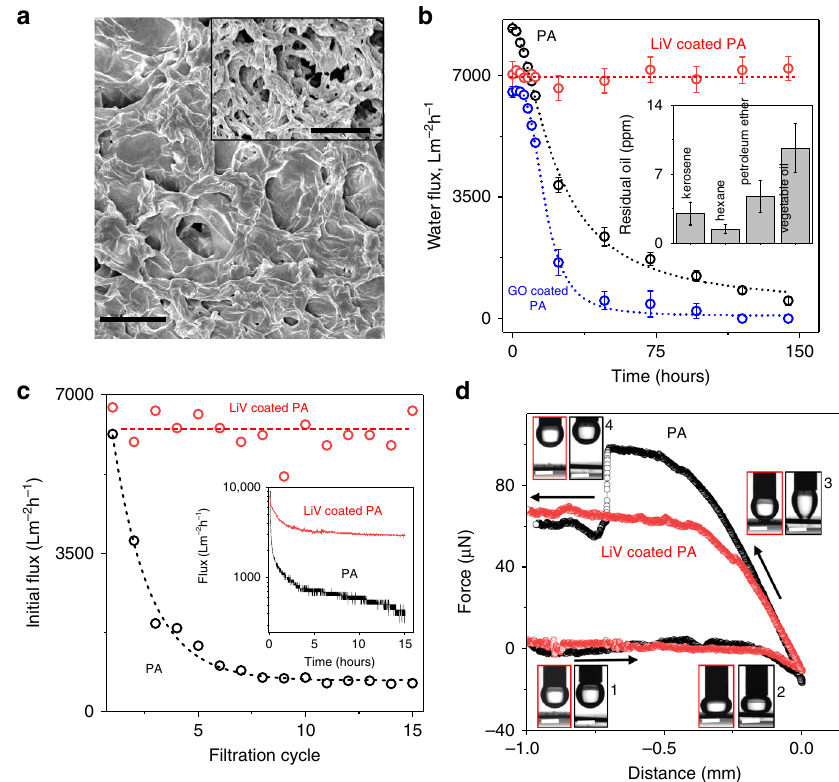
Fig. 3 Oil – water separation performance. a SEM image showing the topography of Li-vermiculite (LiV)-coated ( ∽ 30 nm) polyamide (PA) membrane. Scale bar is 1 μ m. Inset: scanning electron microscopy (SEM) image of bare PA membrane. Scale bar; 3 µ m. b Water fl ux through the LiV-coated PA,